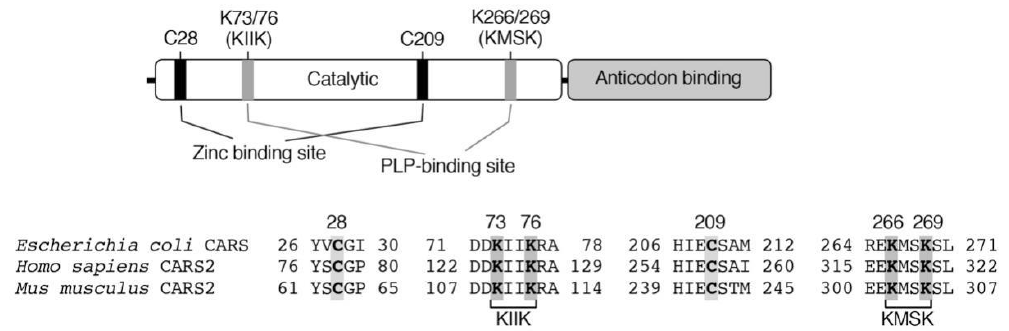
Figure 3. CARS-mediated incorporation of CysSSH into cysteinyl-tRNA and translation-coupled protein S-sulfhydration. PPi, pyrophosphate.